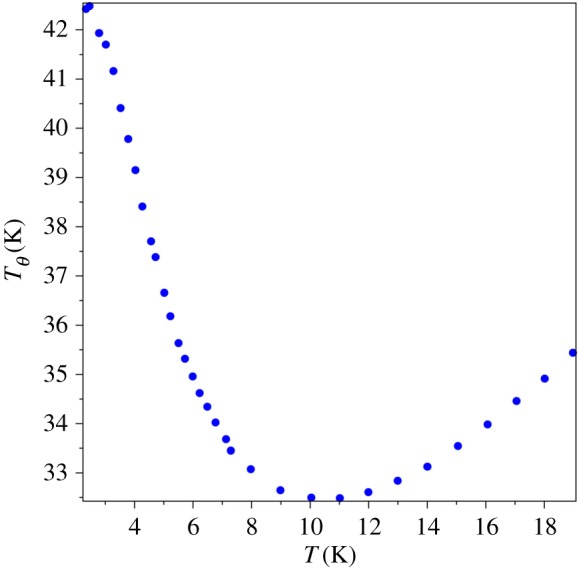
Tθ (K) for vitreous silica [44].